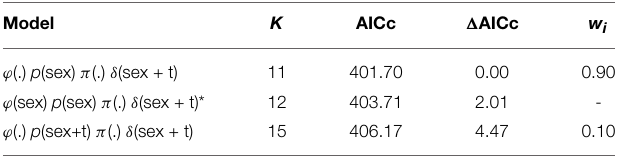
TABLE 1 | Model selection results for models representing hypotheses about sex-based differences in survival.